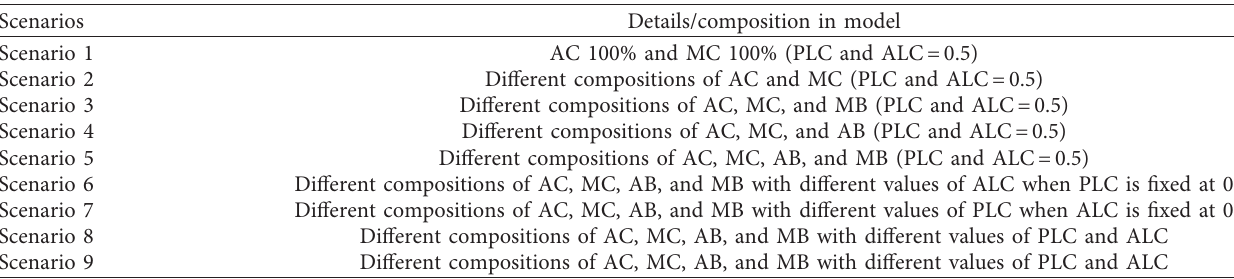
Figure 10: Traffic flow fundamental diagrams for different compositions of AC, MC, AB, and MB with different values of PLC and ALC. Table 7: Details of different